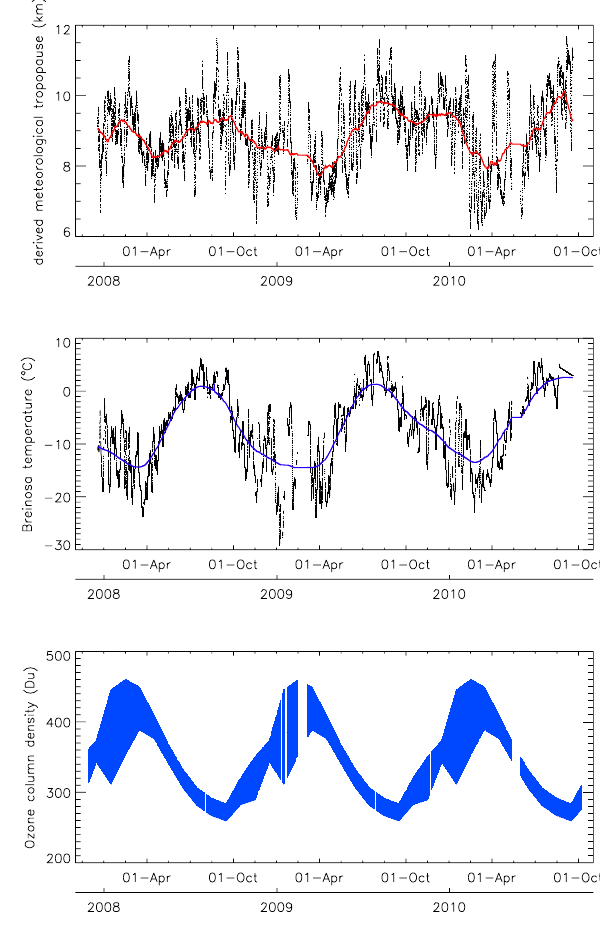
Fig. 6. Upper panel: final estimate of meteorological tropopause derived from radar data (daily medians of hourly measurements in black, overlaid by 30-day Lee-filtered version in red). Middle panel: surface air temperature at Breinosa (daily means in black, overlaid by 30-day Lee-filtered version in blue). Bottom panel: correspond- ing daily means of ozone column density with line width indicating standard